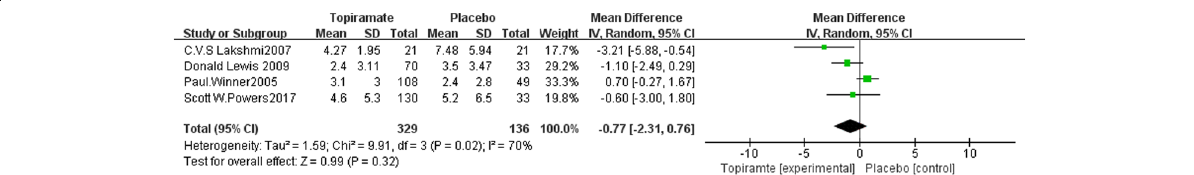
Fig. 4 Forest plot of comparison: headache days per 28-day period of topiramate versus